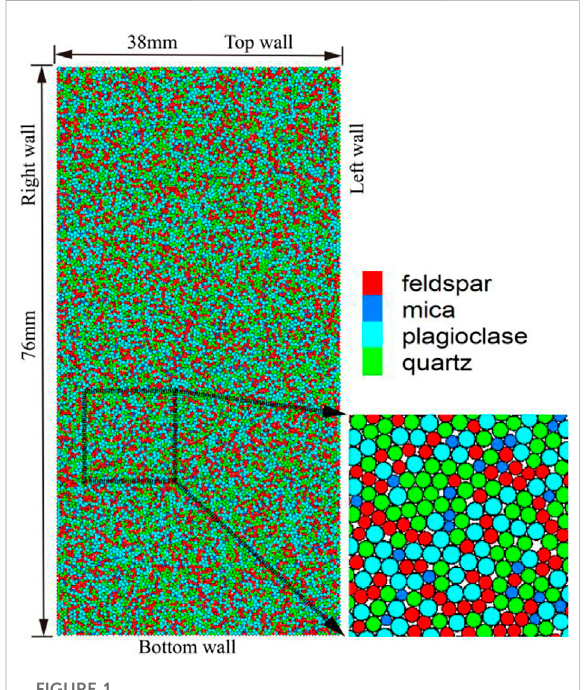
FIGURE 1 Thermal-mechanicalcouplingveri fi cationcalculationmodel.